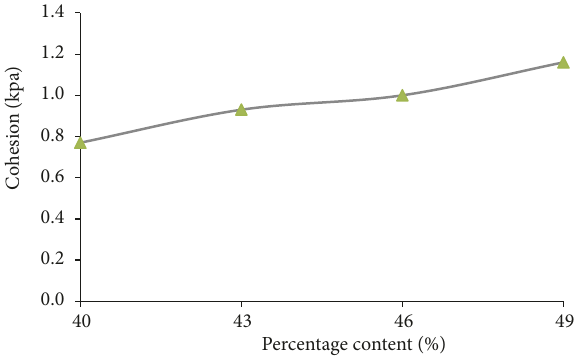
Figure 7: Influence of standard sand on the internal friction angle.